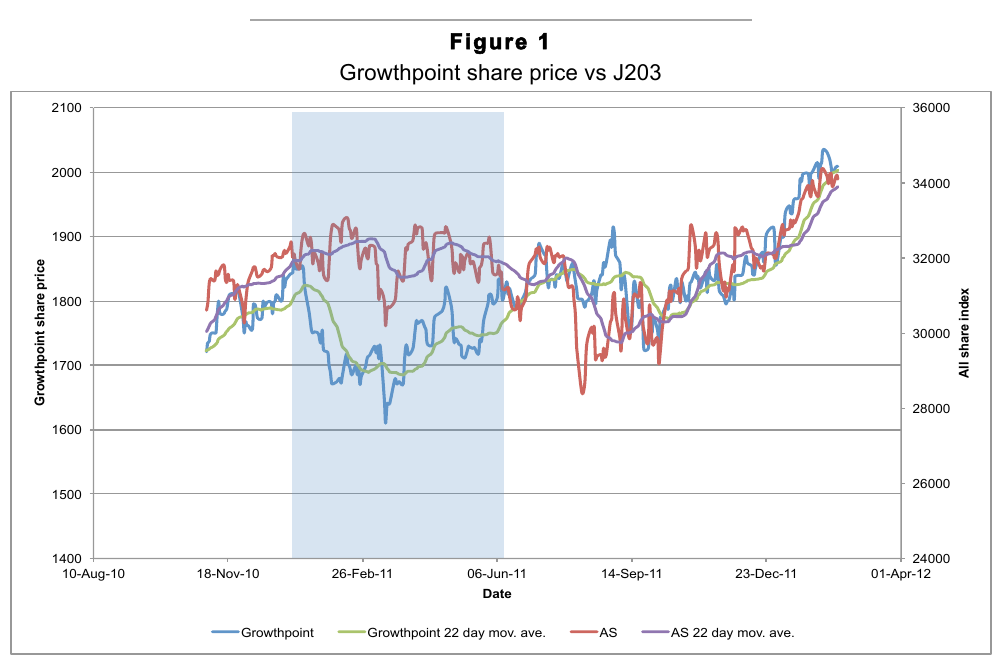
Growthpoint Growthpoint 22 day mov. ave. AS AS 22 day mov.